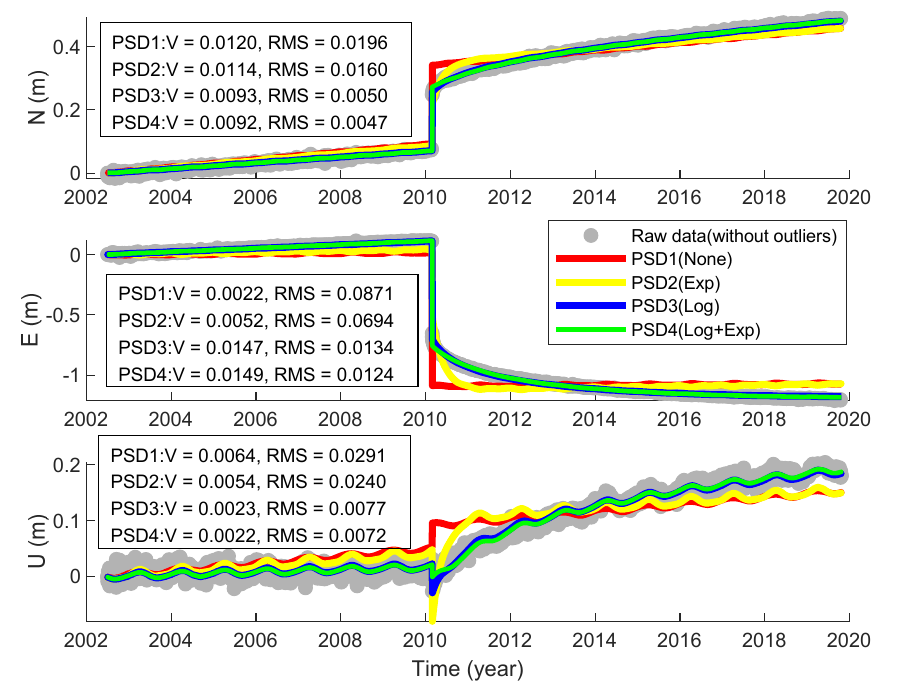
Figure 11. Analysis results of the PSD model with different forms (None, Exp, Log, Exp + Log).